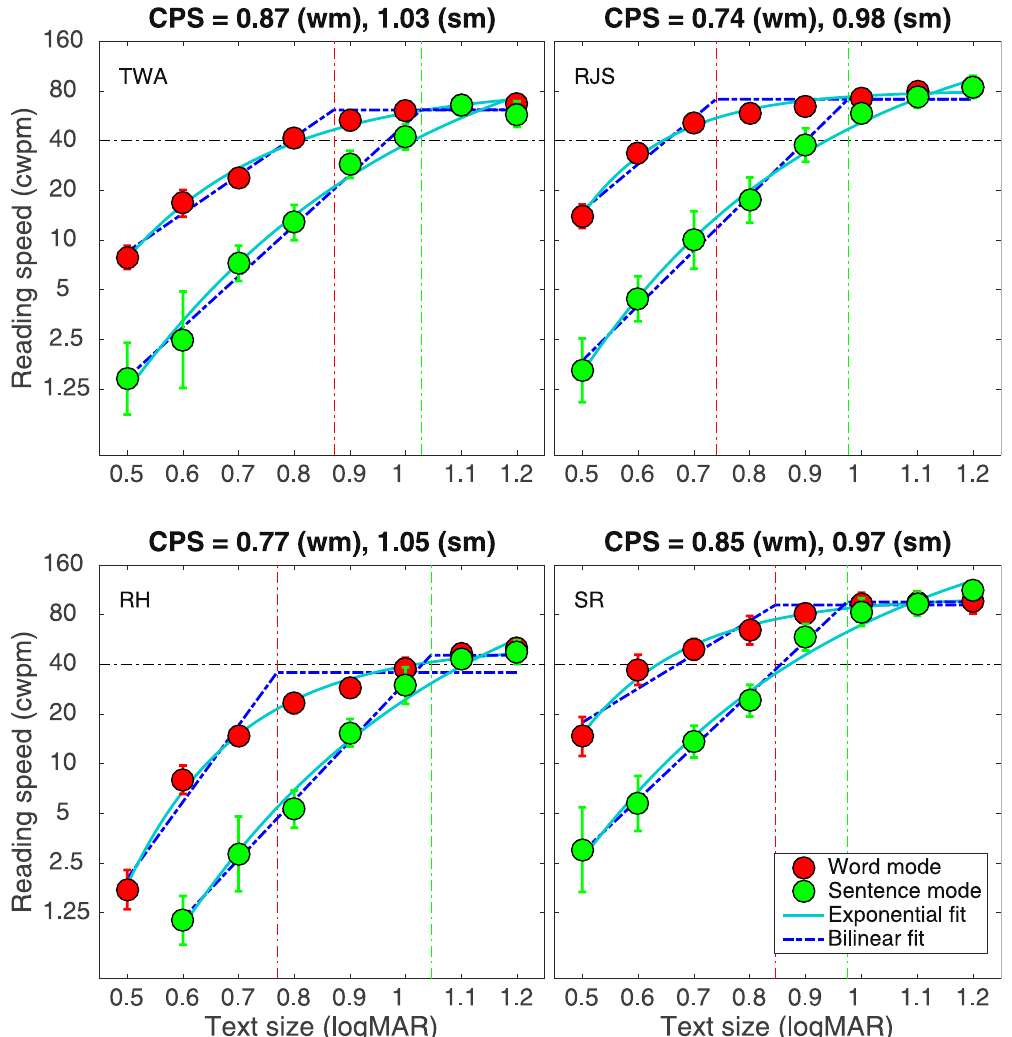
Figure 1. Mean reading speed (correct words per minute ± 84% CI) as a function of text size (logMAR) for four observers, for both Word Mode (red circles) and Sentence Mode (green circles). Blue dashed line through each data set show the best fit of a bilinear function (see Supplementary Material for details). The elbow of the bilinear functions, demarcated by vertical red (Word Mode, wm) and green (Sentence Mode, sm) dashed vertical lines, specifies the critical print size (CPS), which is reported at the top of each panel. Solid blue line through each data set show the best fit of an exponential function (see Supplementary Material for details). Note that observer RH was unable to read any words in Sentence Mode at a text size of 0.5